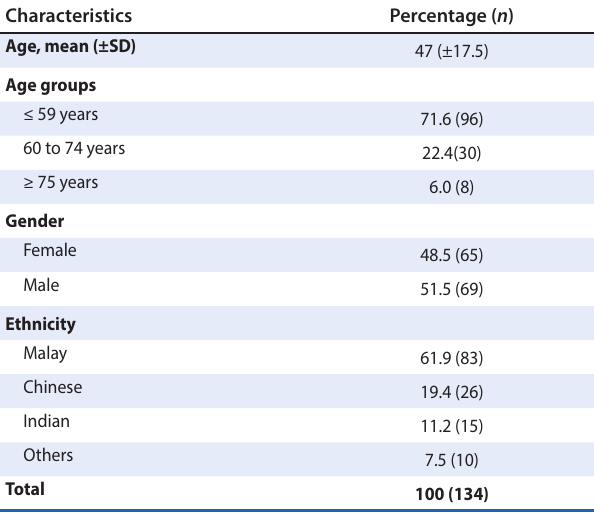
Table 1: Demographic characteristics of ACDR in general Characteristics